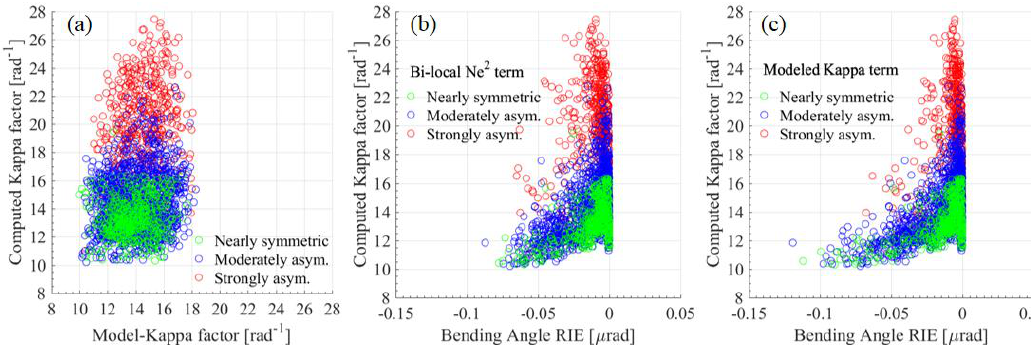
Figure 9. Scatter plots of Kappa factor and bending angle RIE term values at 60 km impact altitude level illustrating the computed Kappa factor vs. the model-Kappa factor (according to [25]) in panel ( a ) as well as vs. the bi-local Ne 2 term in panel ( b ) and vs. the modeled Kappa term in panel ( c ), respectively. Colors of the circles indicate the three classes of nearly symmetric (green), moderately asymmetric (blue), and strongly asymmetric (red) data sets (as illustrated in Figure 3d).